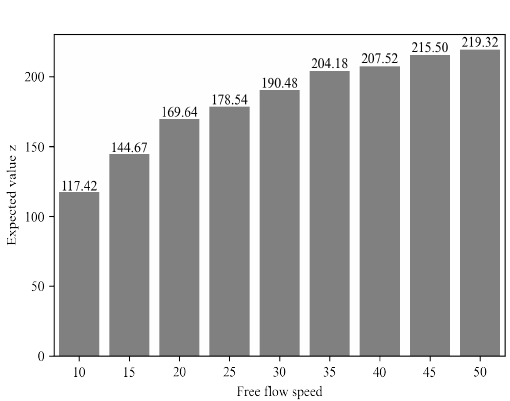
Figure 6. Snapshot of suggested route. Distance (m) Latitude Longitude